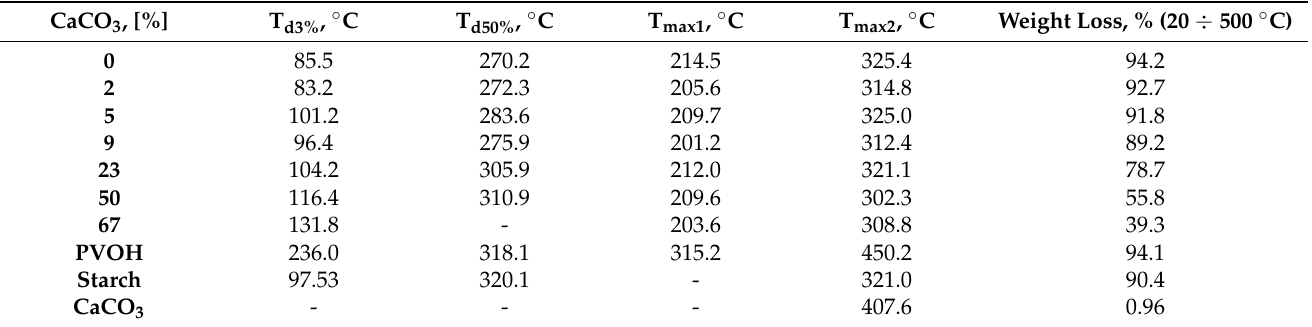
Figure 3. The thermal degradation of the selected quaternary starch - based compound.